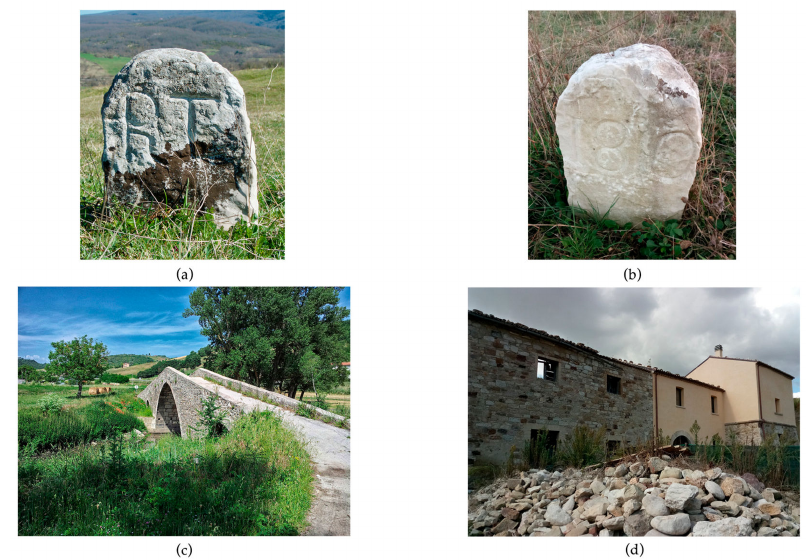
Figure 4. A drove road milestone nearby the locality Torre Santa Maria (Pescolanciano, IS): ( a ) the side with the capital letters RT for Regio Tratturo (Royal drove road), ( b ) the side with the date of